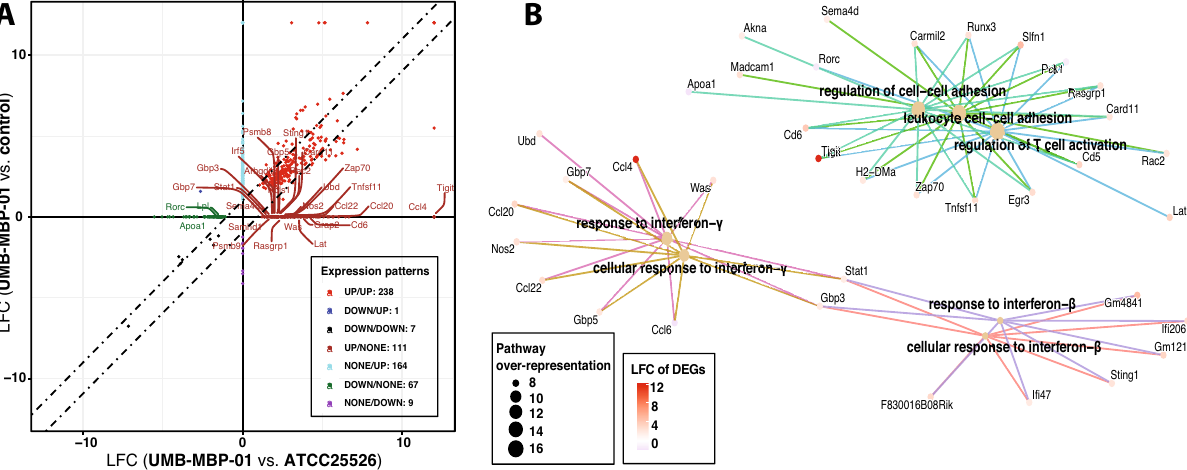
Figure 4. Transcriptome profiling of intestinal tissues in response to ATCC25526 or UMB-MBP-01. ( A ) Quadrant plot to show whether differential expressed genes (DEGs) have the same or opposite relationships between each of the pairwise comparison of UMB-MBP-001 vs control and UMB-MBP-001 vs ATCC25526. DEGs were determined using log2 fold change (LFC) > (+ /−)1 and false discovery rate (FDR) < 0.05. ( B ) Gene- Concept network for most over-represented Gene Ontology (GO) terms to depict over-represented functions based on q-value and gene-count. Over-representation analyses 106 of DEGs that are only different abundant in UMB-MBP-001 vs control but not in ATCC25526 vs control, using GO ontologies performed using enrichGO function of clusterProfile Bioconductor package 107 . For pairwise comparison enrichment analyses for any two conditions, please refer to Supplemental Fig.